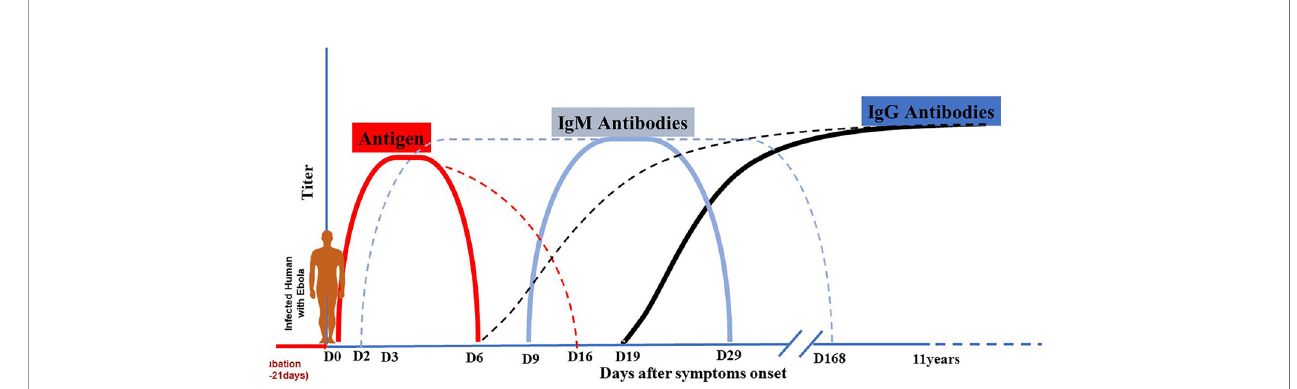
FIGURE 7 | Antigen and antibodies kinetic during EBOV infection. Dotted lines indicate maximal range, and solid lines indicate mean range. After the period of incubation estimated from 2 to 21 days, EVD patients become symptomatic. Virus antigen becomes detectable early after the beginning of symptoms and can persist until day 6-16. Antibody production kinetic during EVD is described as an early occurrence between day 2 and 9 for IgM and between day 6 and 19 for IgG. IgM quickly reach the plateau and fall off around day 29 or longer (day 168); while IgG increase progressively to reach the plateau and last for years (11-40